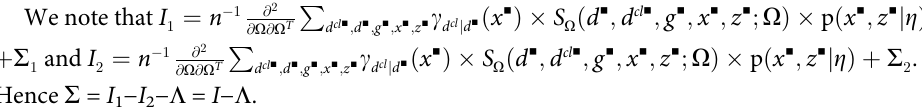
S1 Table. β 6¼ 0. The Bias and Root Mean Squared Error (RMSE) in parameter estimates G× ε 4 from simulations using the usual logistic regression with clinical diagnosis as the outcome (uLR), the pseudo-likelihood approach (pMLE), and our newly proposed pseudo-likelihood approach that accounts for misdiagnosis (pMLE-DX). For these simulations, the study included n controls and n cases. Frequency of ApoE ε 4 allele in the population is 14%. Vari- 0 1 ables Z and Z are Bernoulli with frequencies 0.50 and 0.52, respectively. Frequency of the 1 2 true disease status is 46% in the population; and is 40% among the subpopulation with no ApoE ε 4 alleles, and 82% in the subpopulation with at least one ApoE ε 4 alleles. Frequency of nuisance disease within the clinical diagnosis varies by ApoE4 status pr(D = 1 (cid:3) | D CL = 1, ε 4−) =